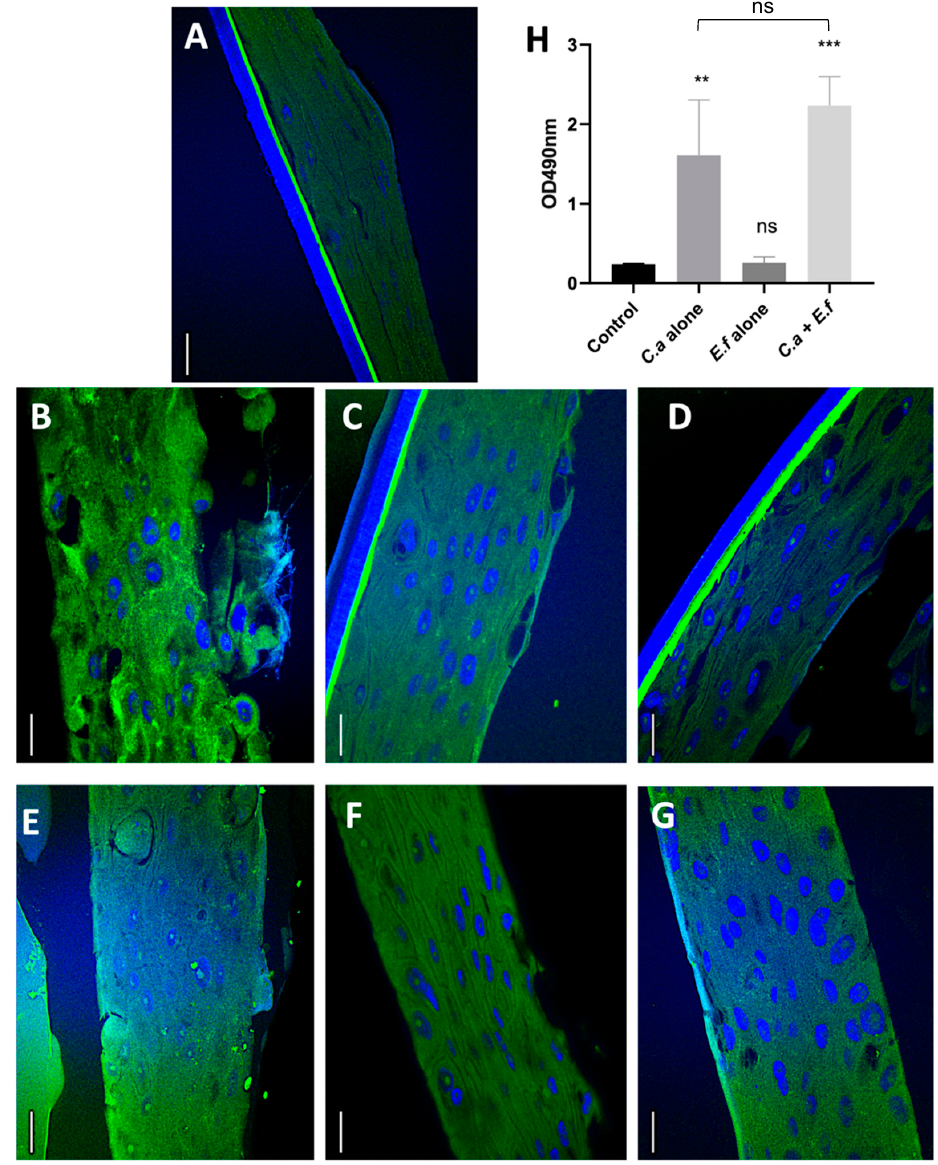
Figure 3. Immunofluorescence staining of E-cadherin in ( A ) uninfected control and ( B–G ) infected tissues in an organotypic oral mucosal model. Thee immunofluorescence staining was performed using monoclonal antibody conjugated with Alexa Fluor 488 (green) and are counterstained with the nucleic acid stain DAPI (blue). Images B, C, and D represent tissues infected with Candida albicans SC5314, Enterococcus faecalis OG1RF, and Candida albicans SC5314 + Enterococcus faecalis OG1RF, respectively, while images E, F, and G represent tissues infected with Candida albicans BF1, Enterococcus faecalis P52S, and Candida albicans BF1 + Enterococcus faecalis P52S. Note that the tissues infected with the reference strain of C. albicans SC5314 (panel B) and C. albicans SC5314 + E. faecalis OG1RF (panel D) loss of tissue integrity on the mucosal surface and sub-surface. Loss of integrity is also evident in tissues infected with the clinical strain of C. albicans , though to a lesser extent than observed with the reference strain as visualized in panel B. Scale bars in A–C and G–I = 50 µm. Graph in panel H shows results of the Lactate dehydrogenase (LDH) assay indicating a moderate but insignificant increase in LDH released in the dual-species infected tissues compared to the C. albicans infected tissues. ** denotes p ≤ 0.01 and *** denotes p ≤ 0.001, and ns denotes p > 0.05. C.a — C. albicans ; E.f — E. faecalis.